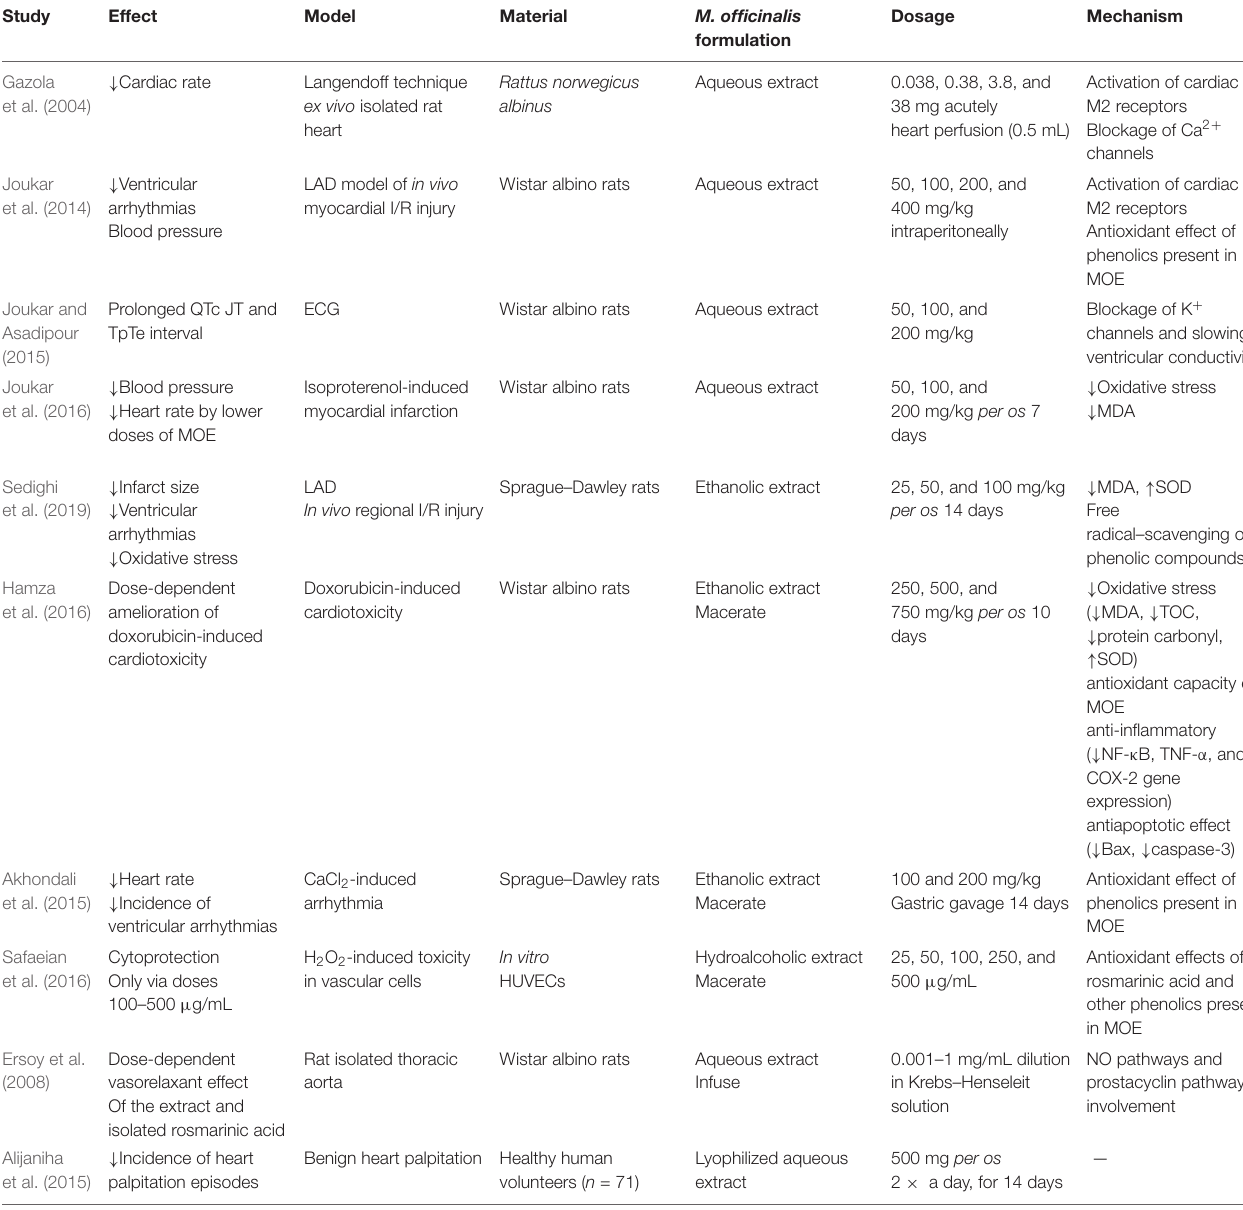
TABLE 2 | Cardiovascular effects of M.